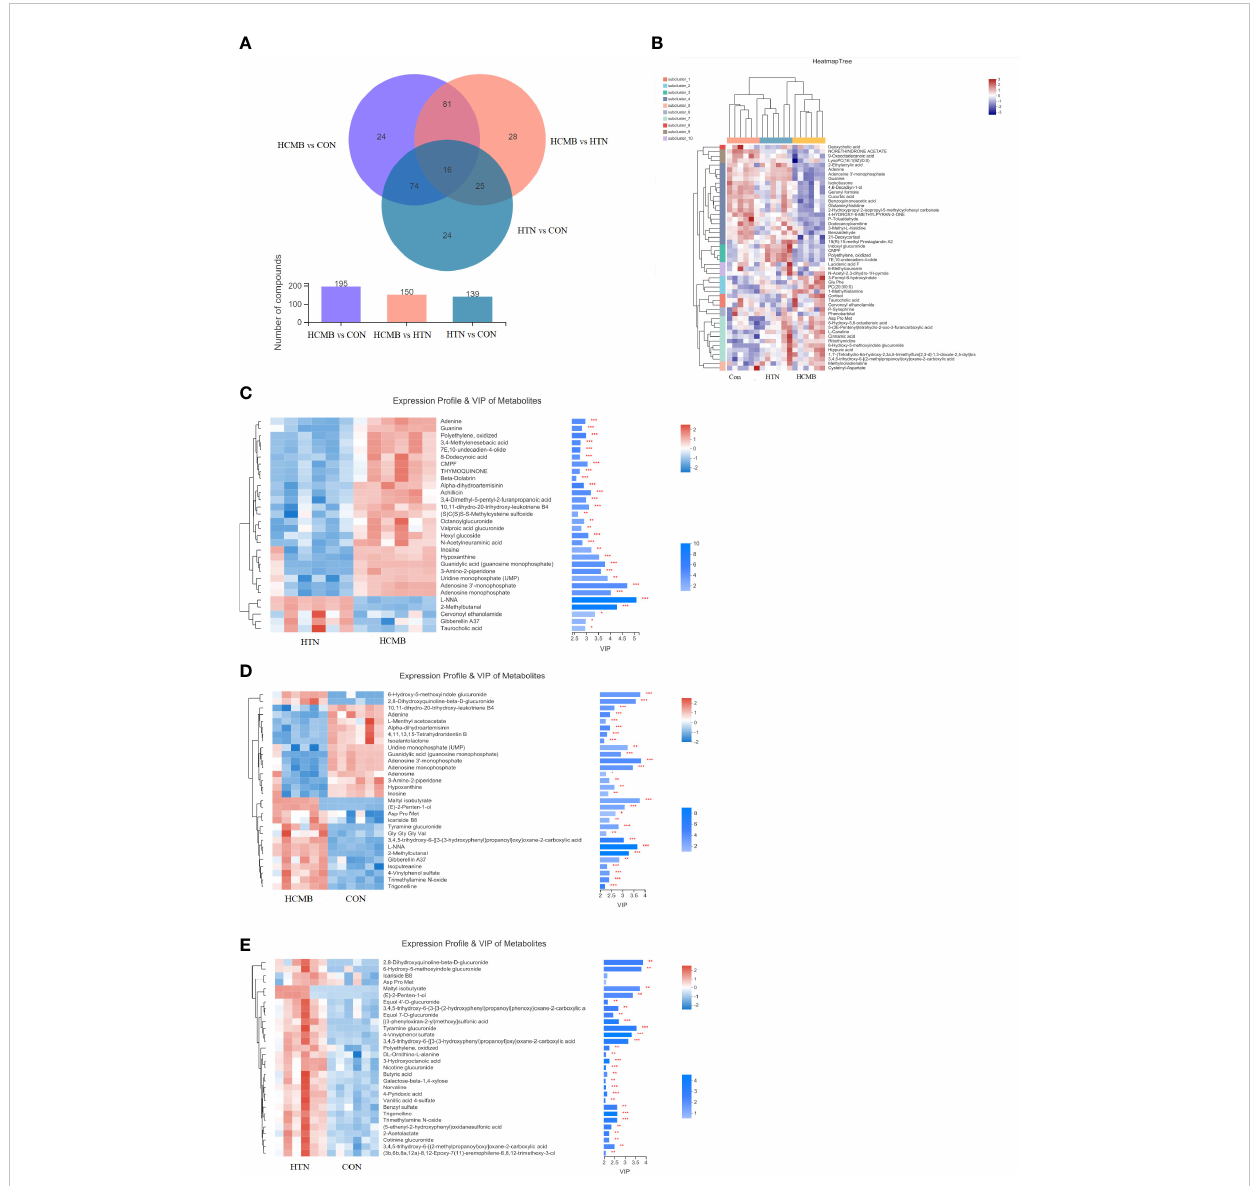
FIGURE 7 Venn diagram and heat map of HCMB with HTN and CON groups. (A) . Venn diagram of differential metabolites between HCMB vs CON groups. Note: The overlapping parts of the graph indicate the number of metabolites common to multiple metabolic sets, the parts that do not overlap indicate the number of metabolites speci fi c to that metabolic set, and the numbers indicate the corresponding metabolite numbers. The second bar graph indicates the number of metabolites contained in each metabolite set. The third graph is used to depict the number of metabolites contained in each part of the Venn diagram, the number of intersecting parts and the number of difference parts. (B) . Heat map of differential VIP values between HCMB, HTN and CON groups. In the graph, each row denotes a metabolite and each column a sample. The numbers under the color bar at the bottom right of the graph represent the trend in expression, and the colors in the graph show the relative expression of the metabolite in that group of samples. The name of the metabolite is on the right, and on the left is a tree diagram of metabolite clustering. The closer two metabolite branches are to one another, the closer their expressions are. The names of the samples are displayed on the lower side, and the upper side displays a tree diagram of sample clustering. The expression patterns of all metabolites in these two samples are more closely correlated with one another the closer two sample branches are to one another. (C) . Clustering diagram of differential metabolites between HCMB vs HTN groups. (D) . Clustering diagram of differential metabolites between HCMB vs CON groups. (E) . Clustering diagram of differential metabolites between HTN vs CON groups. (C-E) Each row represents a metabolite, the color indicating the size of the relative expression of that metabolite in that group of samples, and the color gradient corresponds to the size of the value is shown in the gradient color block. The left side is a metabolite clustering tree; the closer the branches, the closer the expression pattern of all metabolites within the sample. Each column represents a sample, and the sample name is below. The metabolite VIP bar is located on the right side; its length indicates how much the metabolite contributed to the difference between the two groups; its default value is not less than 1, and a larger value indicates that the metabolite contributed more to the difference between the groups. The P value, which is represented by the bar ’ s color, re fl ects the importance of the metabolite difference between the two groups. The deeper the color, the smaller the P value, and the bigger the -log10(P-value). Right side * denotes P<0.05, ** denotes P<0.01, and *** denotes P<0.001. CON, control group; HTN, hypertension; HCMB, hypertensive cerebral